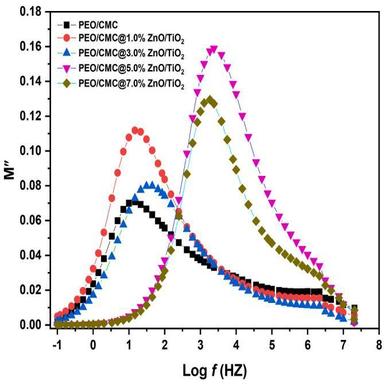
Dependence of Mʹʹ on frequency for PEO/CMC composite and PEO/ CMC filled 1.0, 3.0, 5.0 and 7.0 wt% of ZnO/TiO2 NPs.